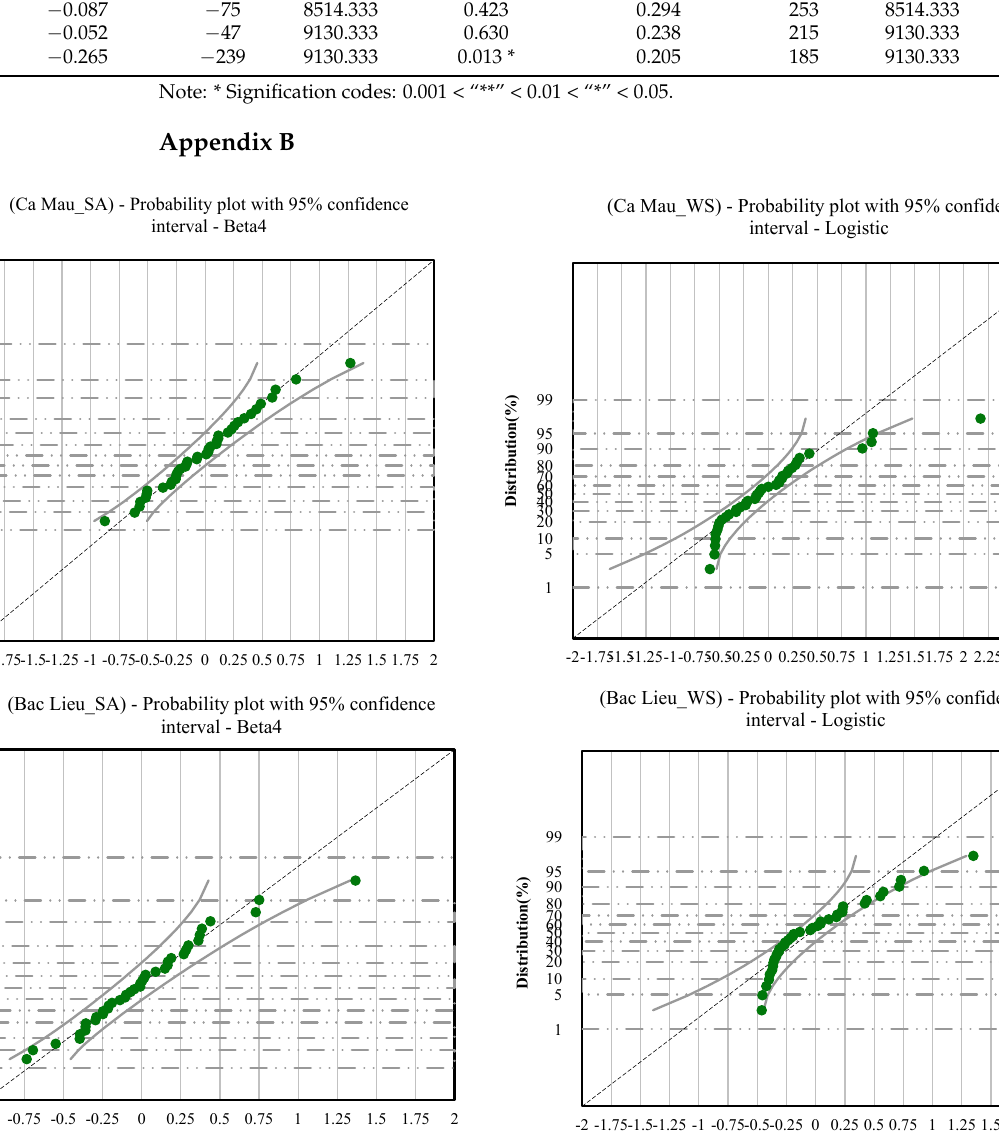
Figure A1. Probability plot for SPI seasons at Ca Mau and Bac Lieu stations.